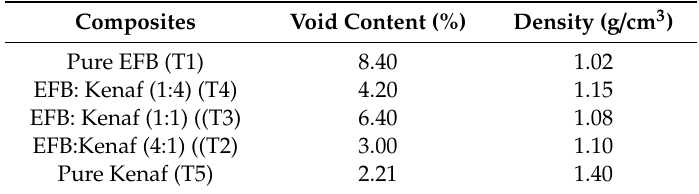
Table 8. Void content and density of oil palm EFB/kenaf woven fiber-reinforced epoxy-based hybrid composites.